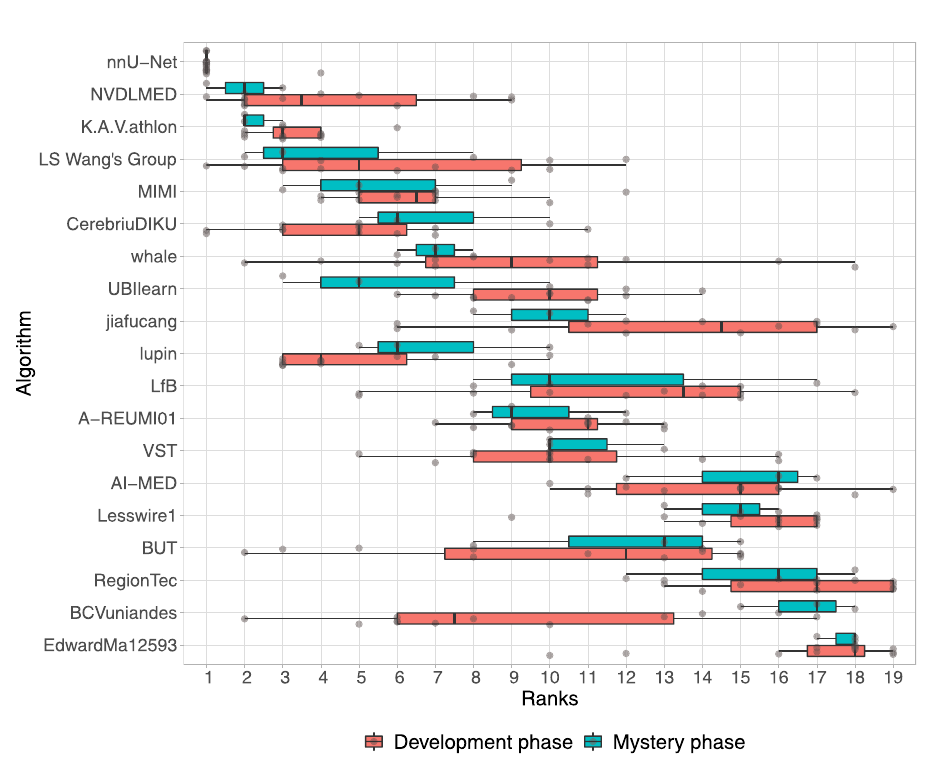
Fig. 5 Dot- and box-plots of ranks for all 19 participating algorithms over all seven tasks and thirteen target regions of the development phase (red) and all three tasks and four target regions of the mystery phase (blue). The median value is shown by the black vertical line within the box, the fi rst and third quartiles as the lower and upper border of the box, respectively, and the 1.5 interquartile range by the horizontal black lines. Individual ranks are shown as gray circles. Impact of the challenge winner . In the 2 years after the chal- was 0.94 (0.91, 0.95) for the colon task, 0.99 (0.98, 0.99) for the lenge, the winning algorithm, nnU-Net (with sometimes minor hepatic-vessel task and 0.92 (0.89, 0.94) for the spleen task. This modi fi cation) competed in a total of 53 further segmentation shows that the rankings for the mystery phase were stable against tasks. The method won 33 out of 53 tasks with a median rank of 1 small perturbations. NATURE COMMUNICATIONS| (2022) 13:4128